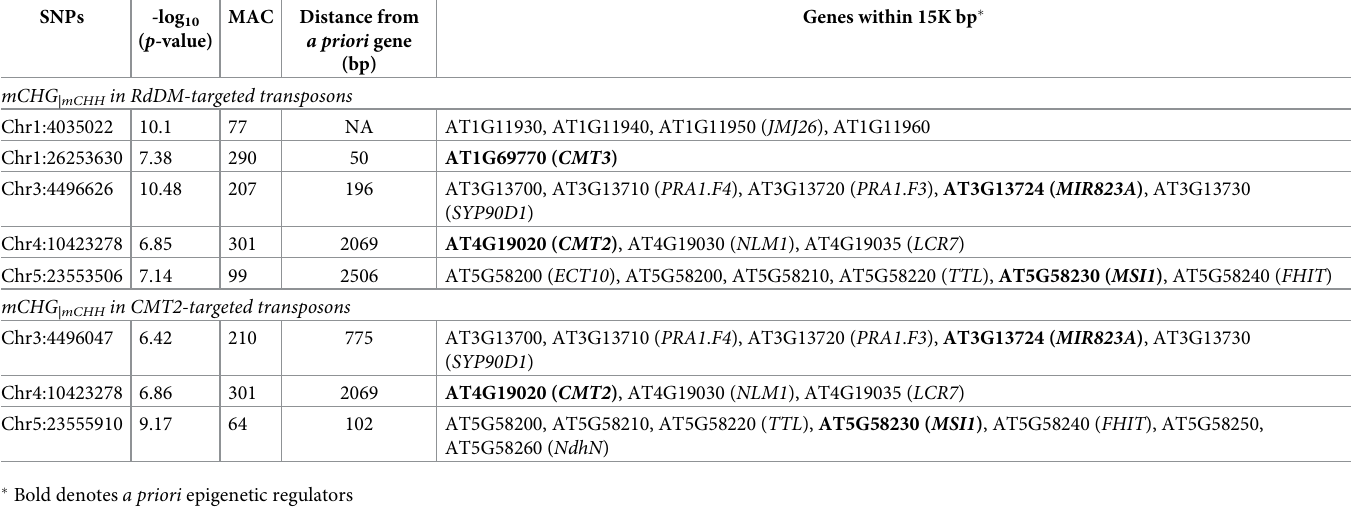
Table 1. Significant conditional GWAS hits for mCHG |mCHH �